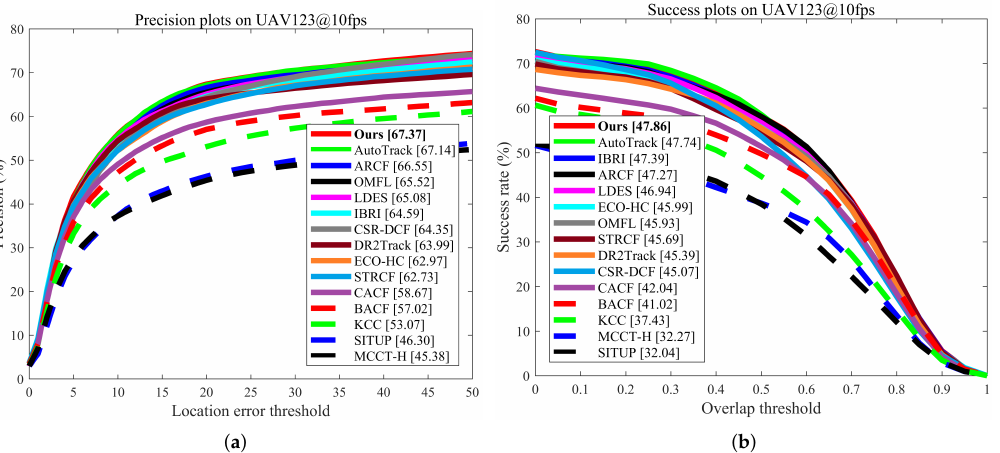
Figure 5. Overall evaluation on the UAV123@10fps [45] benchmark. ( a ) Precision plots. ( b ) Success plots.